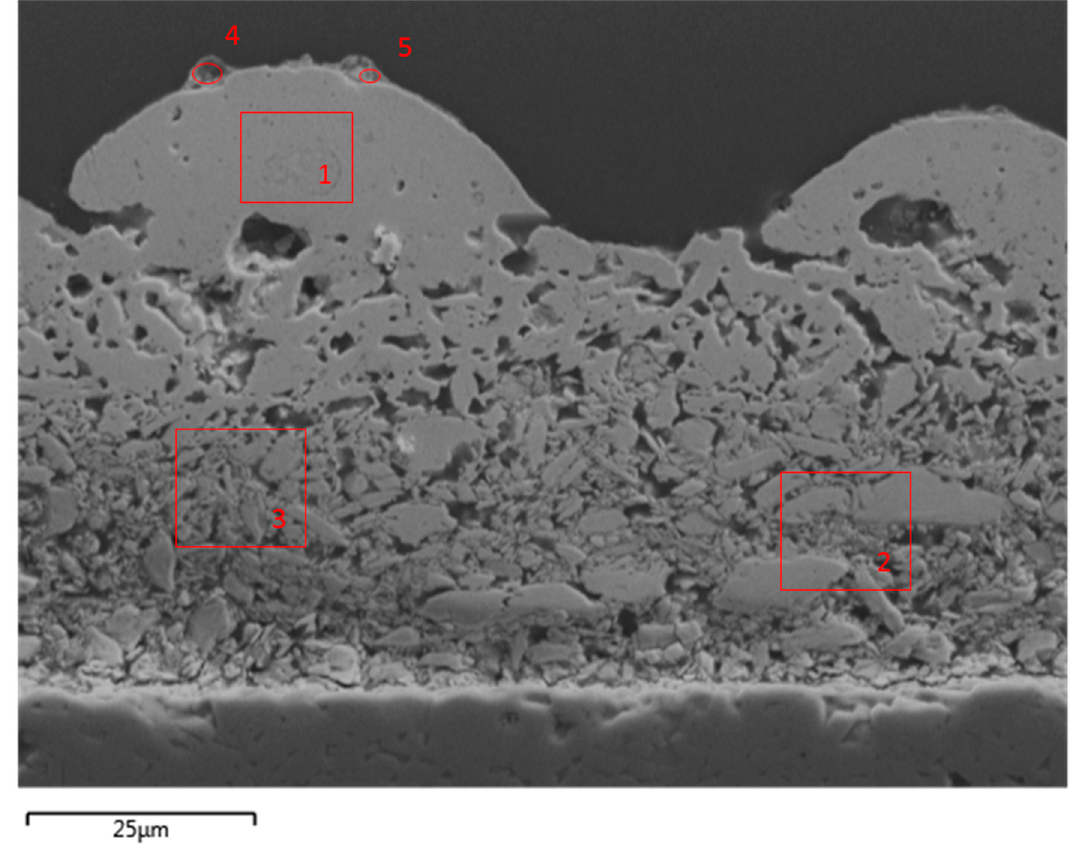
Figure 10. Scanning electron microscopy (SEM) image of area under investigation for energy-dispersive X-ray spectroscopy (EDX) with 5 areas, where elemental composition was analyzed.